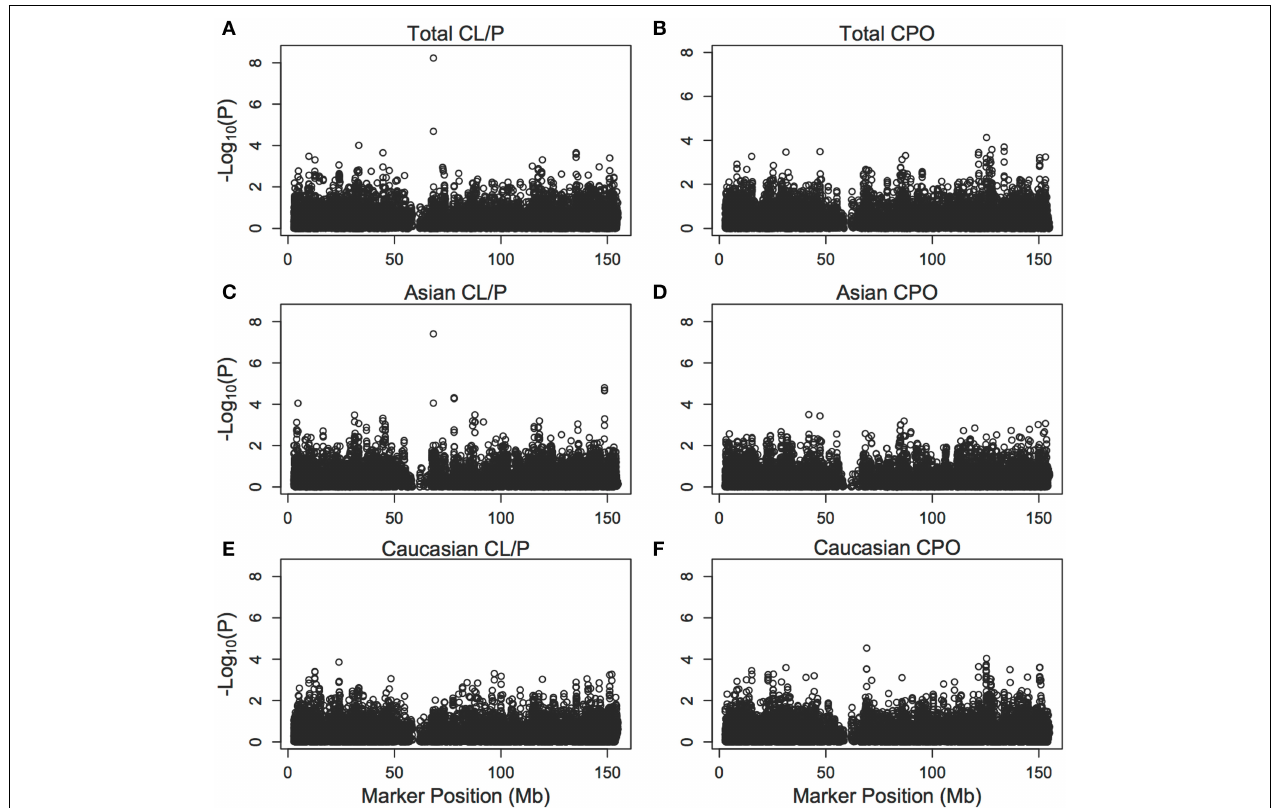
FIGURE 5 | Individual single nucleotide polymorphism significance of the cleft example. The p -values [shown as − log 10 ( p )] are calculated from PIX-LRT withtheEMusingdbGaPdatafromfamilieswithoralcleft.Alog-additivemodel is assumed for the risk in affected daughters and a combined score is used to